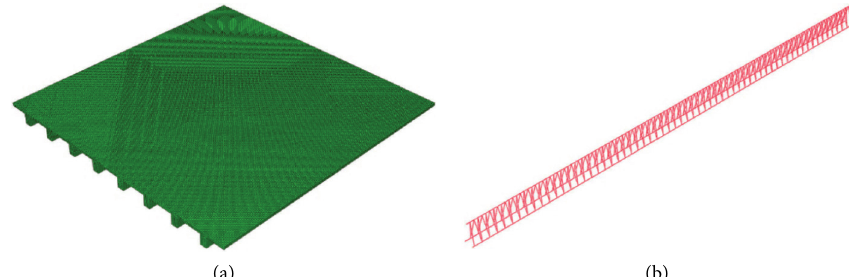
Figure 8: Bidirectional concrete slab finite element model. (a) Set of concrete elements. (b) Steel truss used in joists.